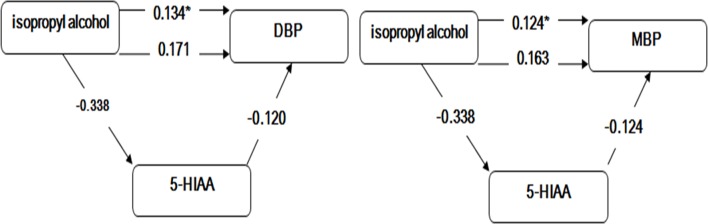
The mediating effects of 5-HIAA on DBP and MBP.*: the standard coefficients relating the independent variable to the dependent variable after adjusting for 5-HIAA and potential covariates with p<0.05. DBP: diastolic blood pressure. MBP: mean blood pressure. 5-HIAA: 5-hydroxy indole acetic acid.